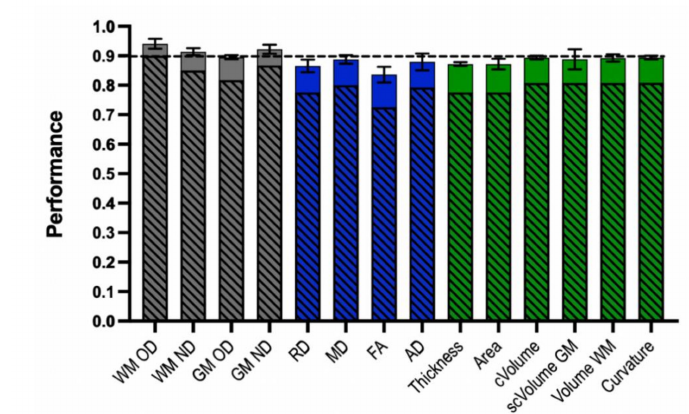
Figure 2. Classification performances of all classifiers. Each bar represents the performance (solid-colored bar: average F-score, shaded area: average accuracy) of each type of classifier trained on one imaging measure, data is presented as mean ± SEM after cross-validation. Grey-colored bars: NDI measure-based classifiers. Blue-colored bars: di ff usion tension imaging (DTI) measure-based classifiers.